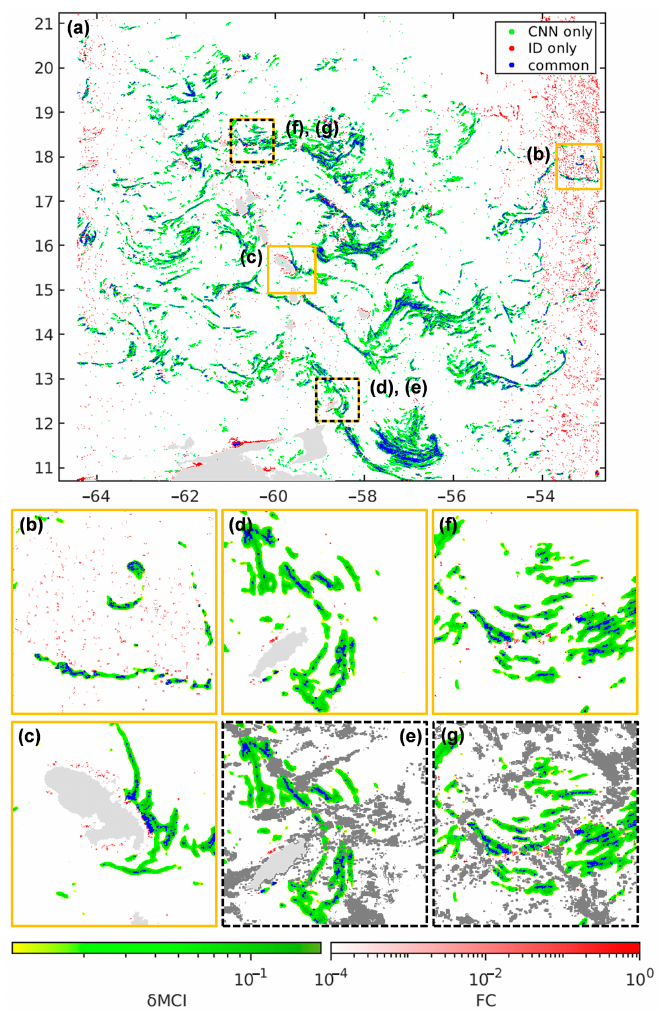
Figure 5. ( a ) Sargassum detections from OLCI with the CNN and ID methods: detected by both methods (blue), detected by the CNN but not by the ID method (green), and detected by the ID method but not by the CNN (red); ( b – g ) sub-images from ( a ) with a color scale for the ID and CNN detections; and ( e , g ) are respectively ( d , f ) with a cloud mask. MCI data for the calculation of the FC, cloud (dark gray) and land masks (light gray) come from Schamberger et al. [52]. OLCI image from 8 July 2017.